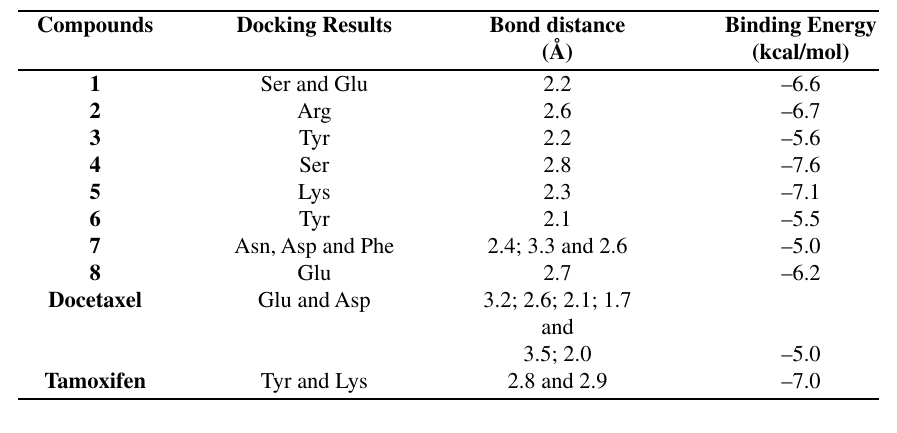
Table 4. Docking results of the compounds (1–8) , Docetaxel and Tamoxifen